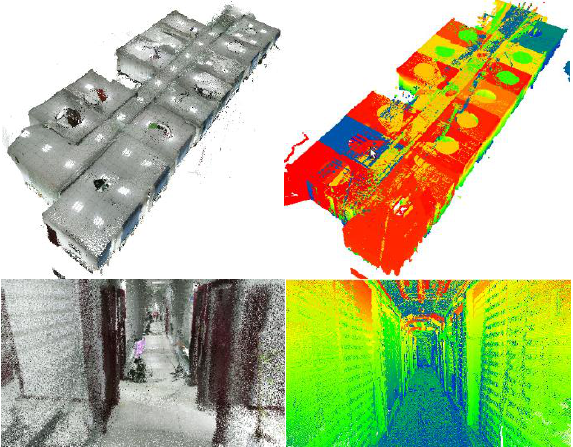
Figure 11. Point cloud captured by out sensor array (left) and LiDAR